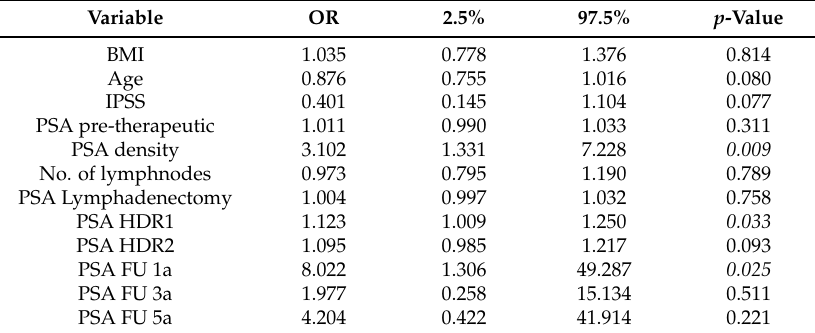
Table 7. p -Value for relevant parameters regarding local recurrence during